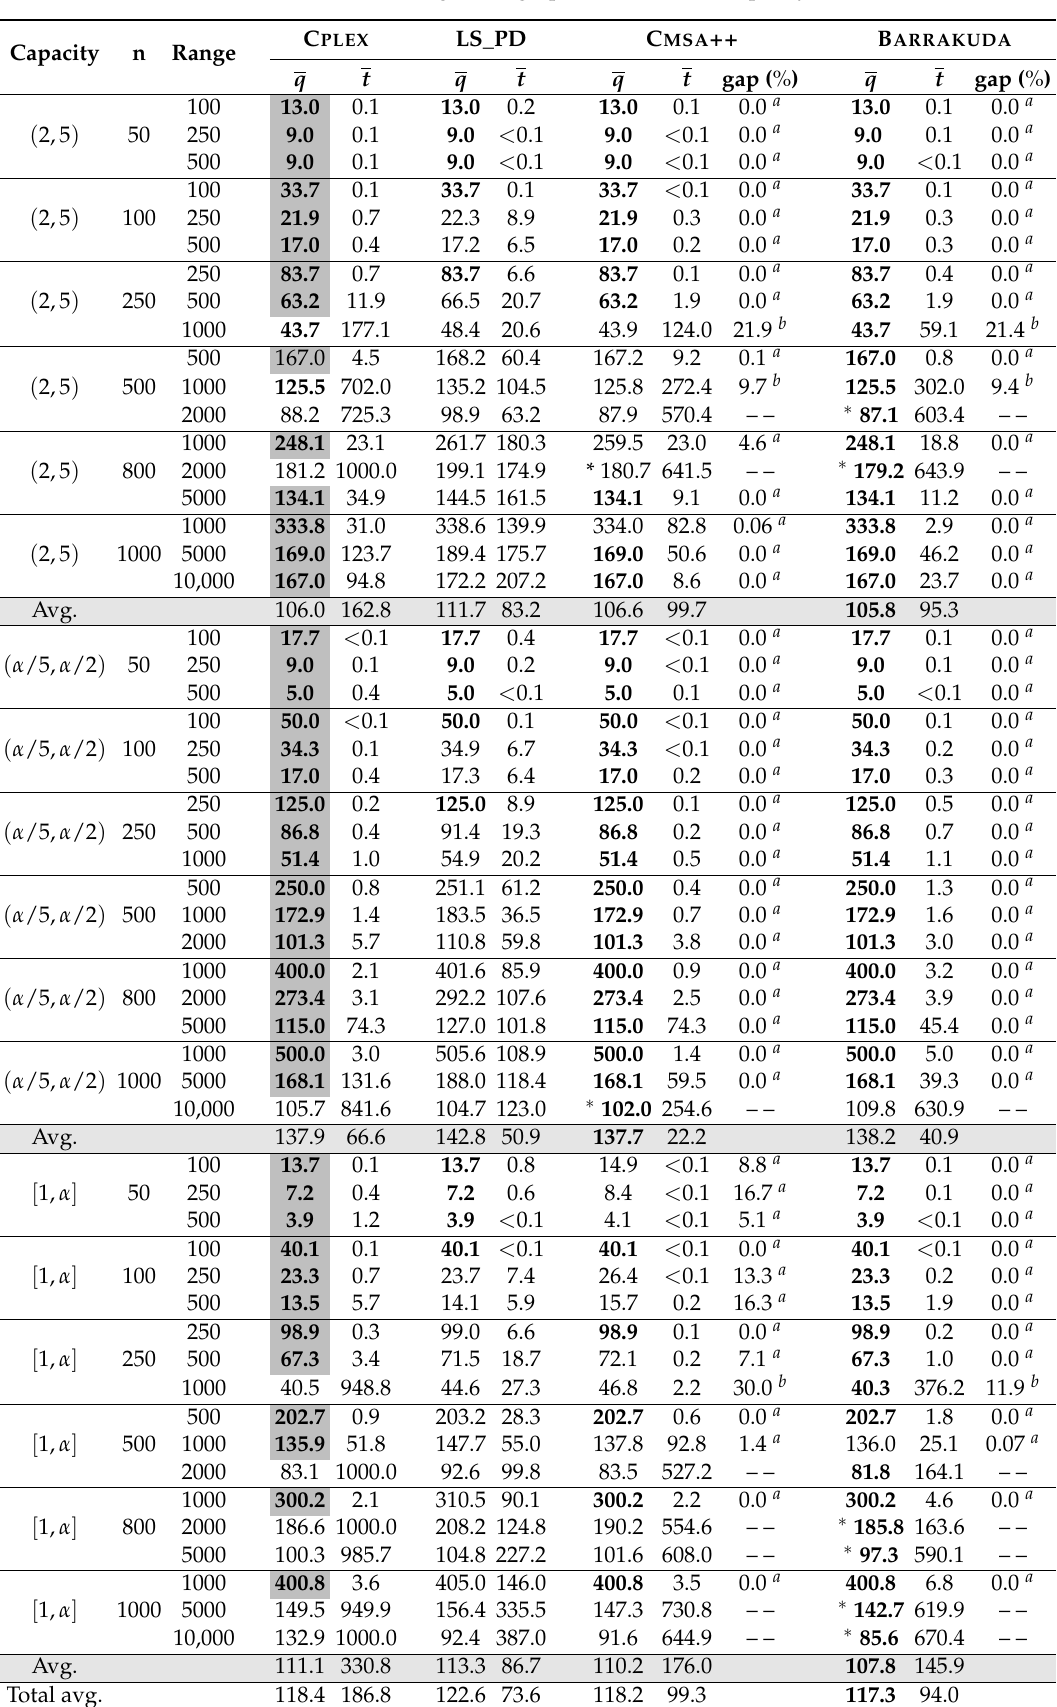
Table 6. Results for general graphs with variable